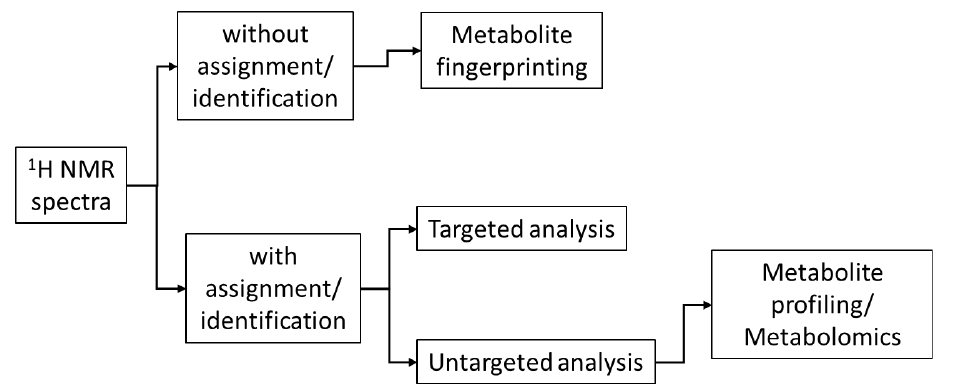
Scheme 1. Classification of high-resolution 1 H NMR spectroscopy’s application types for food anal‐